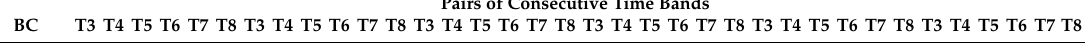
Table 11. Failures coding (F-codes) for primary energy uses and CO 2 intensities, for the di ff erent building categories in the NR Dbase.